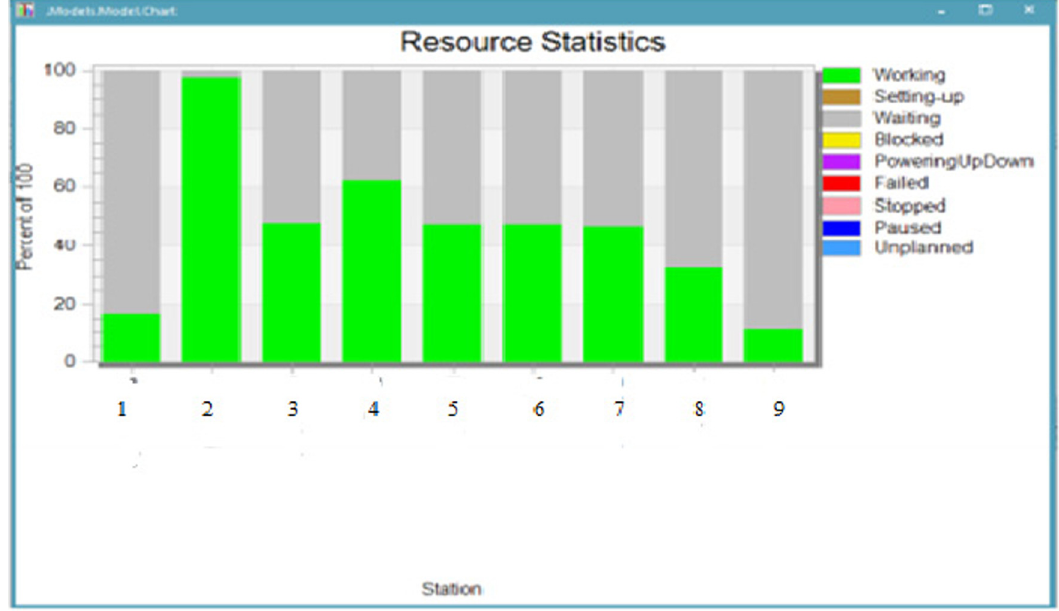
Figure 10: Utilization of devices after connection of three steps in the production enterprise ( 1 – processing, 2 – dryer, 3 – planning, 4 – cutting, 5 – grinding, 6 – drilling, 7 – milling operation, 8 – gluing and surface treatment, 9 – packaging ) . Source: